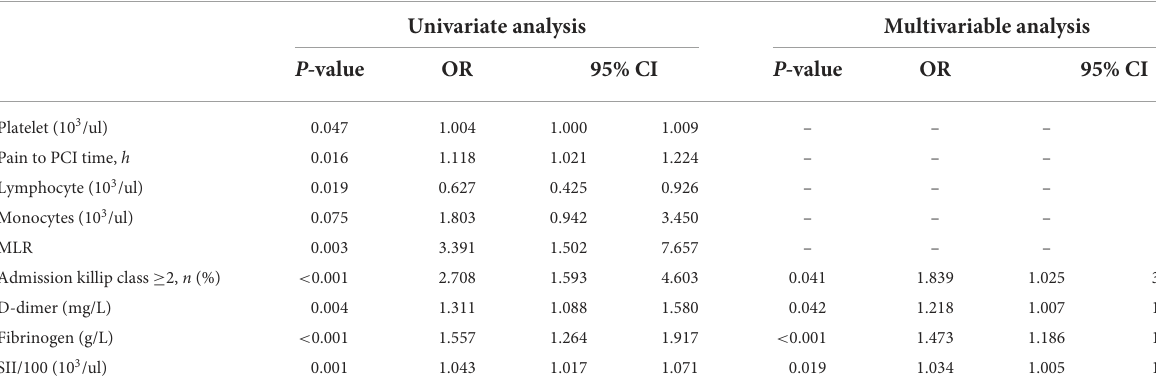
TABLE 2 Independent predictors of no-reflow was determined by multivariate logistic regression analysis.